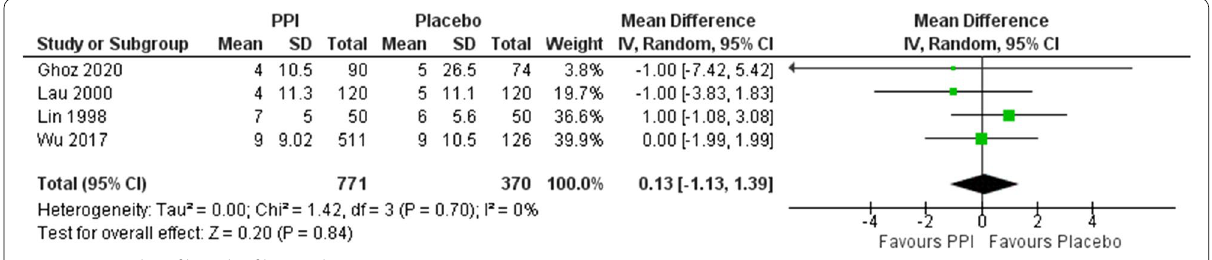
Fig. 6 Forest plot of length of hospital